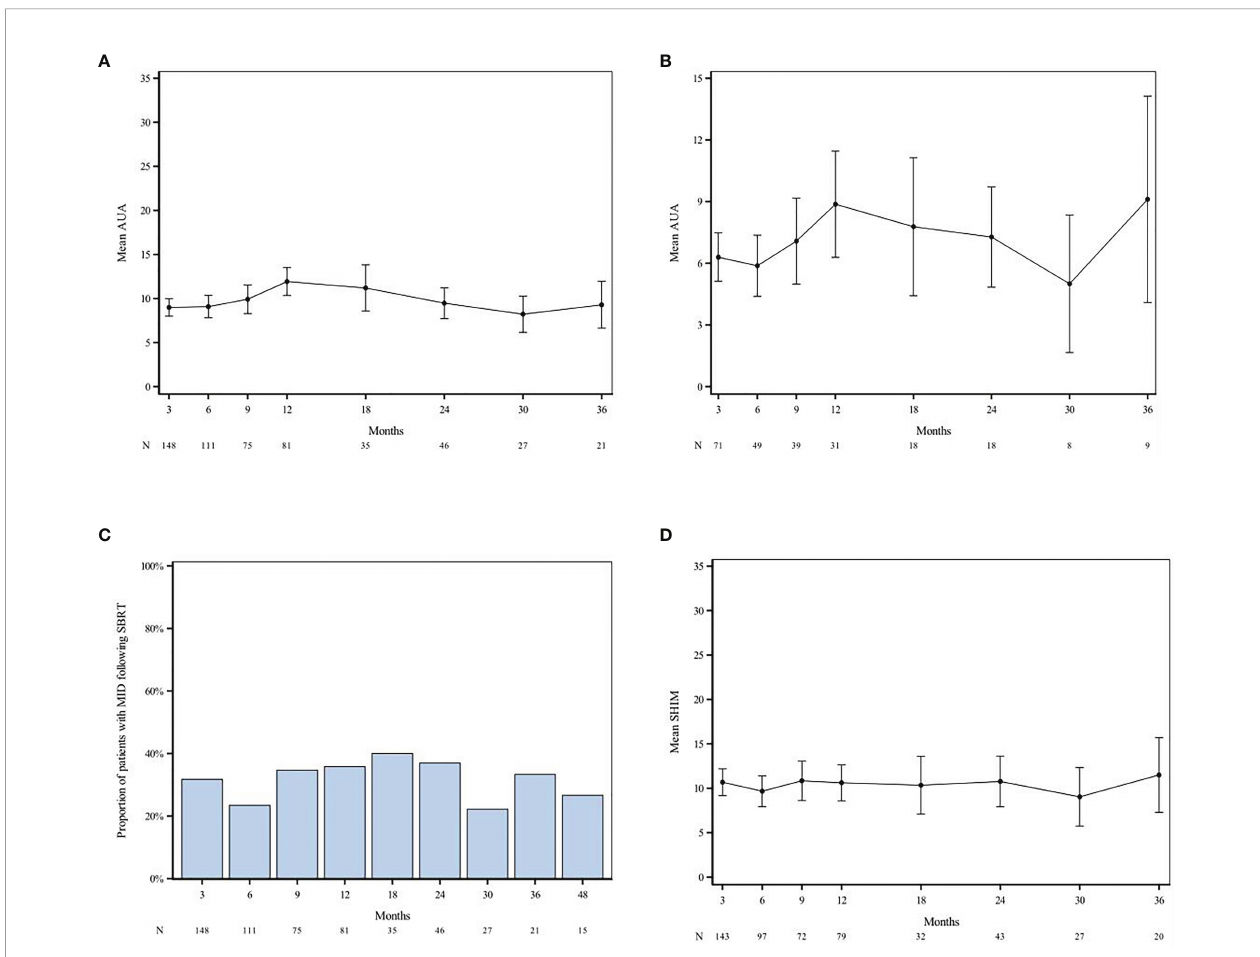
FIGURE 3 | AUA and SHIM scores over time after SAbR. AUA trend amongst all patients (A) and those with low baseline AUA [AUA < 7; (B) ] shows worse outcomes at 12 months +/- 3 months compared to baseline. Difference in MID GU was evident for 31.8%, 23.4%, 35.8%, 37.0%, 33.3%, 26.7% of patients at 3 months, 6 months, 12 months, 24 months, 48 months, respectively (C) . SHIM scores show decline at 6 months post-RT with subsequent plateau and increase (better) sexual function scores after 30 months (D) . “ N ” denotes the number of questionnaires completed at each time point. AUA, American Urological Association; SHIM, Sexual Health Inventory for Men; MID, Minimally Important